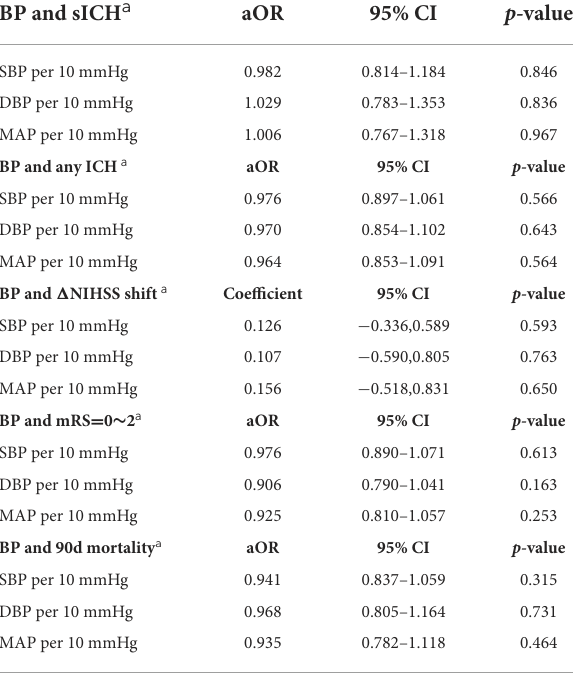
TABLE 2 The interaction between baseline blood pressure and clinical